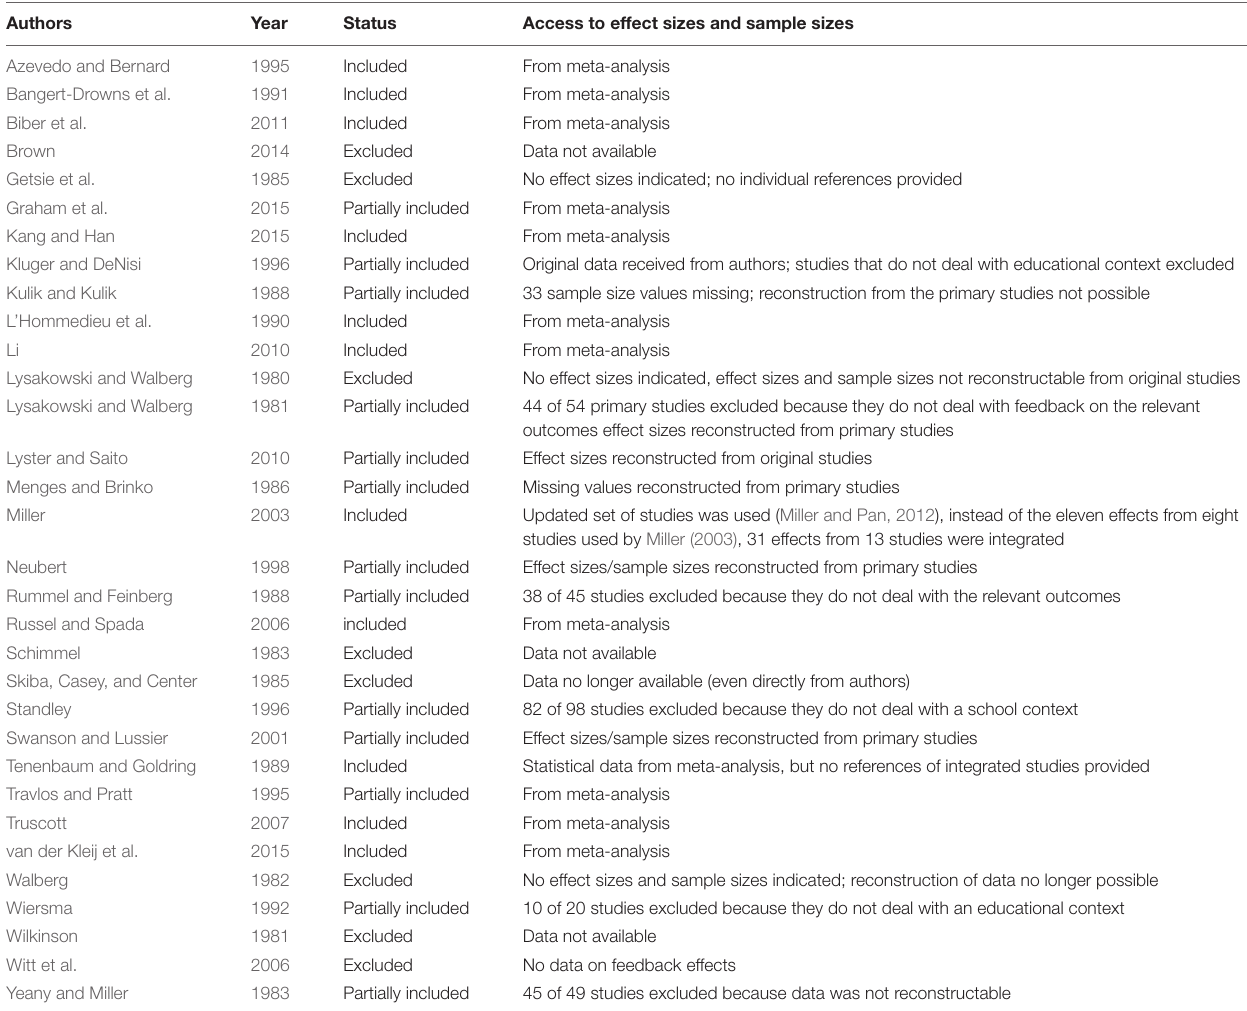
TABLE 1 | Existing meta-analyses investigating the factor